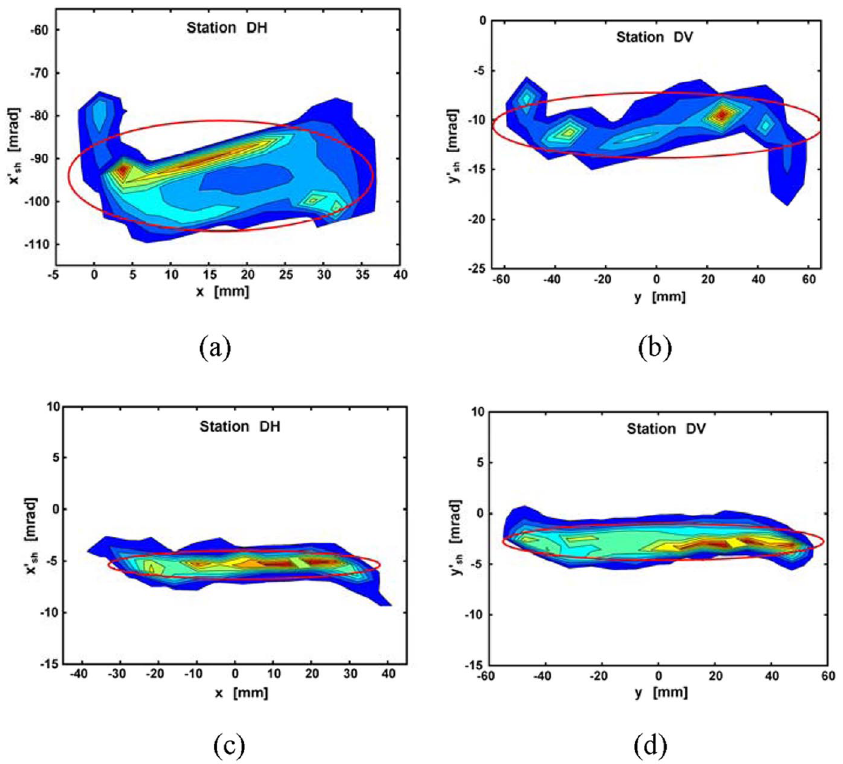
FIG. 14. (Color) Horizontal and vertical emittance diagrams measured at the exit of the injector. (a),(b) First configuration before modification of the beam optics, (c),(d) after modification of the beam optics. To emphasize distortions in these plots of ‘‘sheared’’ phase space, the phase space has been transformed to remove the envelope divergence ( a 0 ; b 0 ) of the beam.